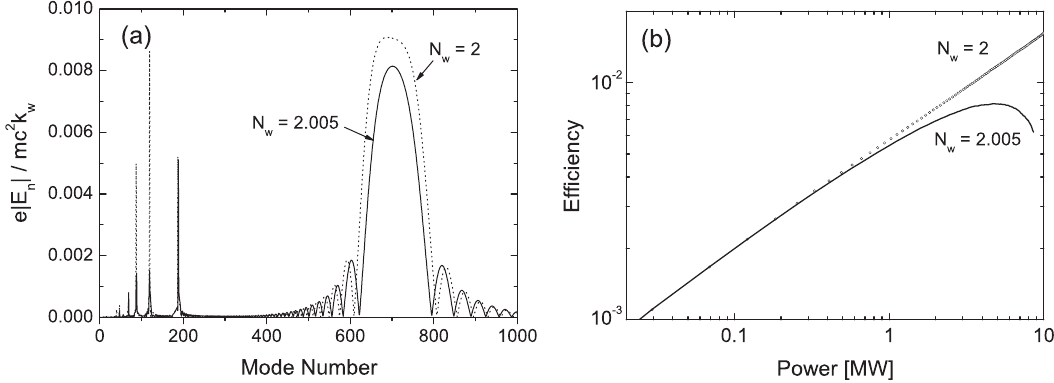
¼ 2 : 005 (a) Mode amplitude spectrum. The broken line shows w